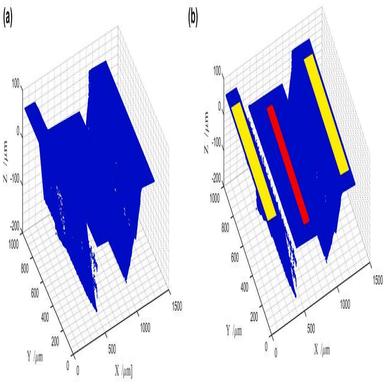
Data visualization: (a) Surface reconstruction of the raw measurement data; (b) Planes extracted for step height calculation.